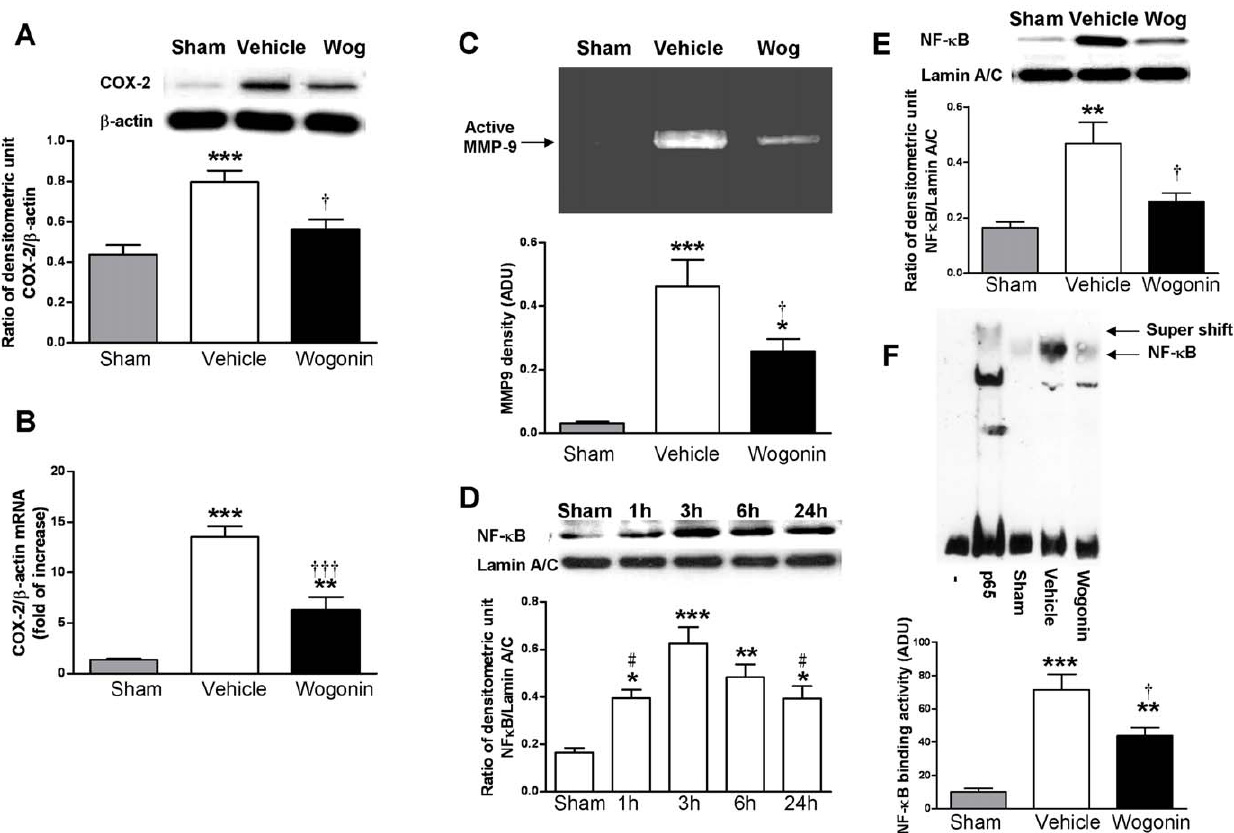
Figure 6. Effects of 40 mg ? kg 2 1 wogonin on COX-2 expression, MMP-9 and NF- k B activation. ( A ) Representative immunoblots and densitometry analysis showed a significant decrease in COX-2 protein levels in the ipsilateral hemispheres of wogonin-treated injured mice at day 1 compared with vehicle-treated injured mice. ( B ) Bar graphs showed that wogonin significantly reduced COX-2 mRNA expression in the ipsilateral hemispheres compared with vehicle-treated injured mice at 6 h post-TBI. ( C ) Representative zymography and densitometry analysis showed that MMP-9 activity was significantly decreased in wogonin-treated mice compared with vehicle-treated mice at day 1. ( D ) Representative immunoblots of nuclearNF- k B p65 in the ipsilateral hemisphere of untreated injured mice. Densitometric analysis showed increased nuclear p65 levels at 1, 3, 6 and 24 h post-injury, with a peak at around 3 h. # P , 0.05 versus 3 h (n=5 mice/time point). ( E ) Representative immunoblots and densitometric analysis showed a significantly greater decrease in nuclear NF- k B p65 levels in the ipsilateral hemispheres of the wogonin-treated injured mice than in the vehicle-treated injured mice at day 1. ( F ) Representative gel shift analysis showing NF- k B DNA-binding activity from a sham control mouse ( lane 3 ), vehicle-treated injured mouse ( lane 4 ), and wogonin-treated injured mouse ( lane 5 ) at day 1. Competition assays for NF- k B DNA-binding activity were performed with a 50-fold excess of unlabeled competitor NF- k B consensus oligonucleotides ( lane 1 ). For the supershift assay, an antibody targeting the p65 subunit of NF- k B was incubated with a nuclear protein sample before the binding reaction ( lane 2 ). Quantification analysis showed that wogonin treatment induced a significantly greater decrease in NF- k B binding activity, expressed in arbitrary densitometric units (ADU), than that induced by vehicle treatment, measured by EMSA.Values are reported as means 6 SEM; * P , 0.05, ** P , 0.01, *** P , 0.001 versus sham controls, and { P , 0.05, {{{ P , 0.001 for wogonin-treated versus vehicle-treated TBI mice (n=7 mice/group).